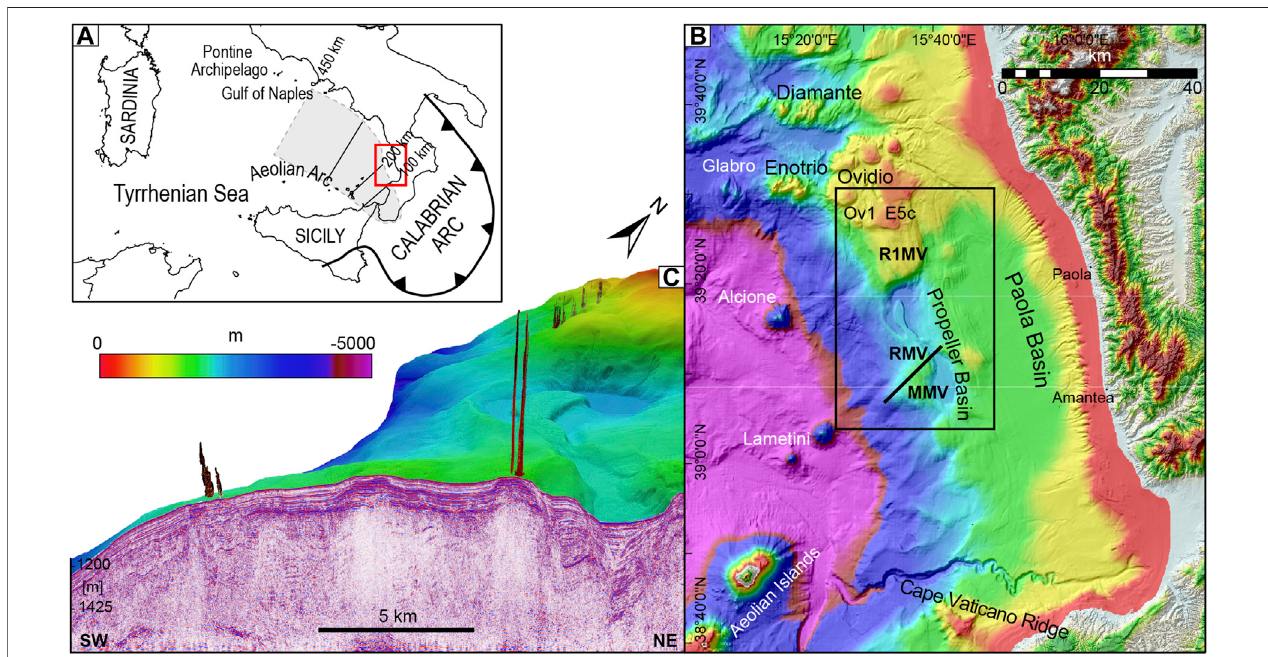
FIGURE 1 | (A) Sketch of the geodynamic setting of the southern Tyrrhenian Sea and Calabrian Arc with the outlines of the depths (from Chiarabba et al., 2008) of thenorthwestwarddippingslaboftheTyrrhenian-Ioniansubductionsystem.Theredrectangleisthefocusareaimagedin (B) . (B) BathymetryofthePaolaBasinandthe surrounding areas, the black rectangle outlines the study area of Figure 2 . (C) 3D scene of the gas fl ares in the water column superimposed to a multichannel seismic re fl ection (MCS) pro fi le whose track line is located in (B) .